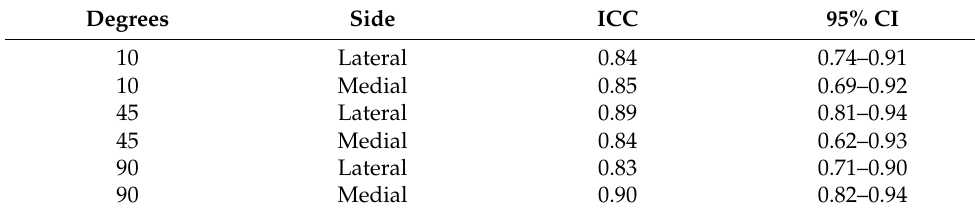
Table 2. Intraclass correlation coefficients for Scenario A.